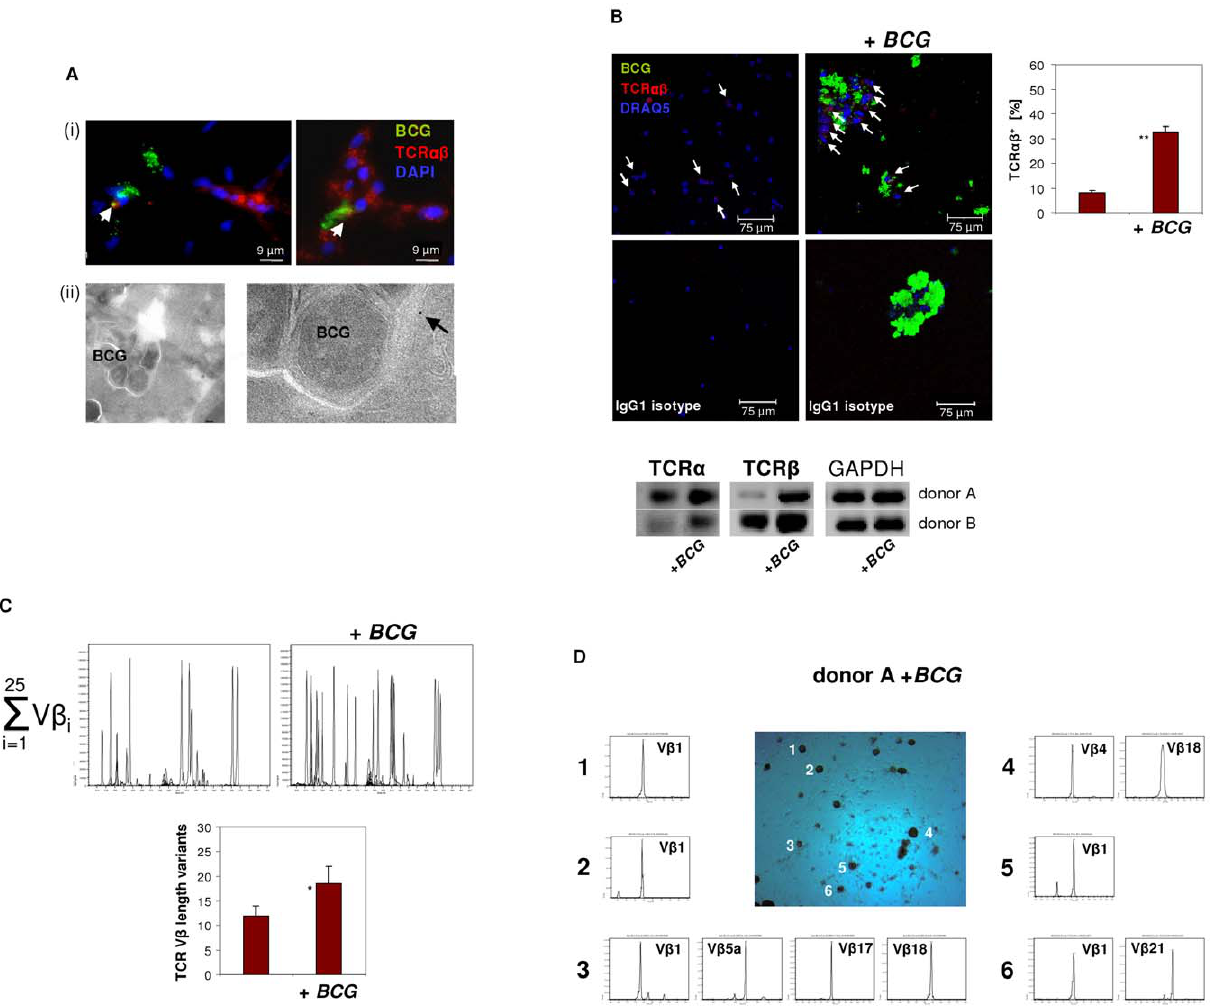
Figure 5. Infection of macrophages with M.bovisBCG induces TCR ab expression invitro . ( A ) Immunofluorescence double-staining demonstrating co-localization of BCG mycobacteria (green) and the macrophage-TCR ab (red) after 6 days of infection (i). Nuclei are stained with DAPI. Arrows highlight two double-stained points of spatial proximity (yellow fluorescence). (ii) Immunogold electron microscopy of a BCG containing phagosome in an IFN c macrophage. The presence of a single TCR ab in the immediate neighborhood of a BCG mycobacterium is shown at a higher magnification (arrow). ( B ) Confocal image of a TCR ab expressing macrophage cluster induced in response to i n vitro infection with BCG . Uninfected IFN c macrophages from the same donor are shown left. White arrows highlight TCR ab + macrophages. A quantitative analysis of the percentage of TCR ab + cells (right) and isotype controls are shown. **p , 0.01. IFN c macrophages were incubated in the presence or absence of FITC-labeled BCG for 6 days. The results represent two healthy individuals (donors A and B). Donor B see Figure S4A. (Bottom) RT-PCR demonstrating increased